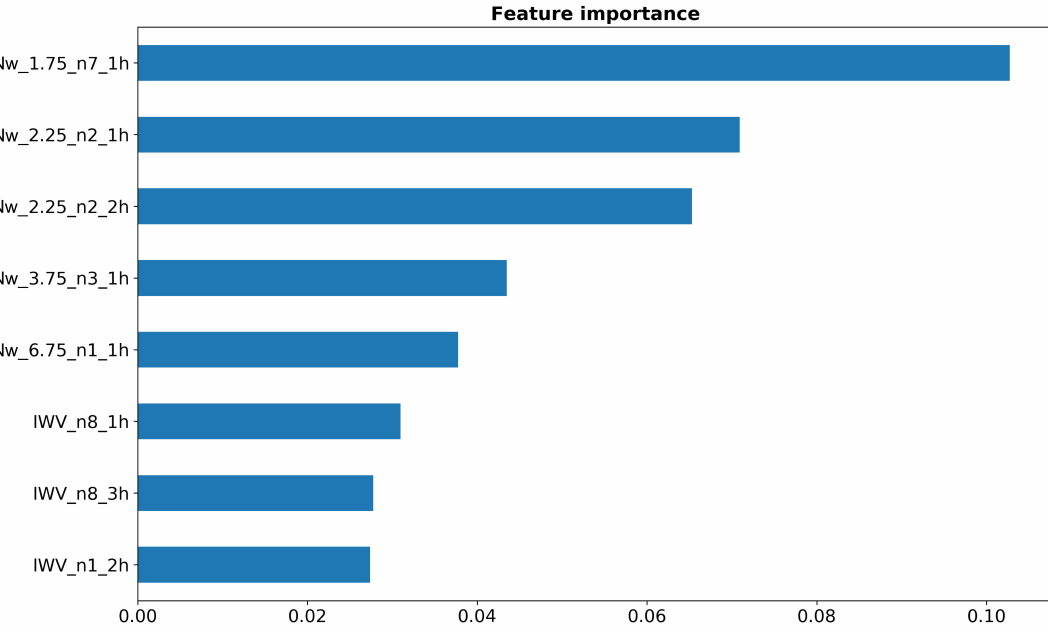
Figure 4. Mean decrease in impurity for the most influential features. Feature names on the chart are created as follows. The first part defines the type of data: IWV or Nw . For tomography data the level is also given, the number before ’n’ indicates a neighbour (as in Figure 1), while ’0’ means the central voxel. The last part with ’h’ indicates the number of hours before the prediction.